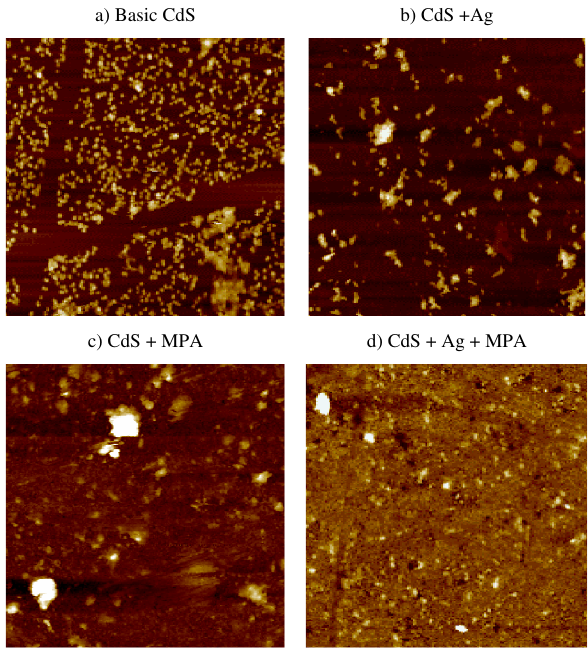
Figure 6. 2D for thin film synthesis at: ( a ) CdS, ( b ) CdS + Ag, ( c ) CdS + MPA, ( d ) CdS + Ag +